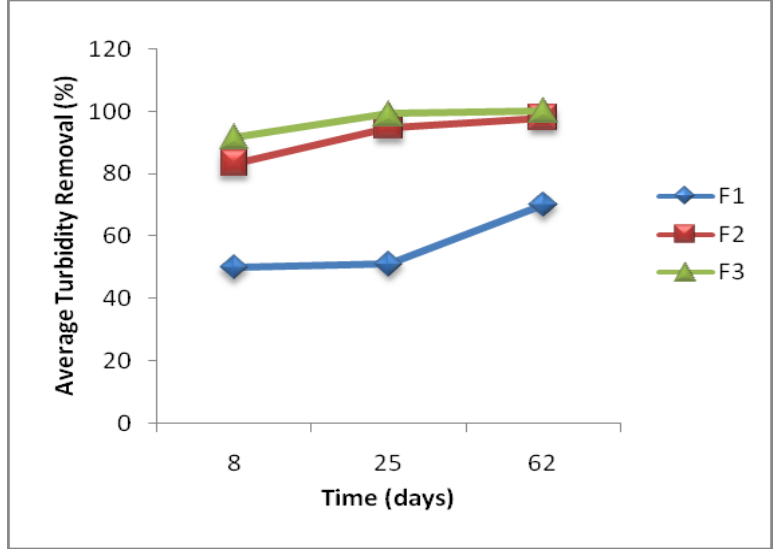
Figure 5. Average turbidity removal (%) over the course of the three filter